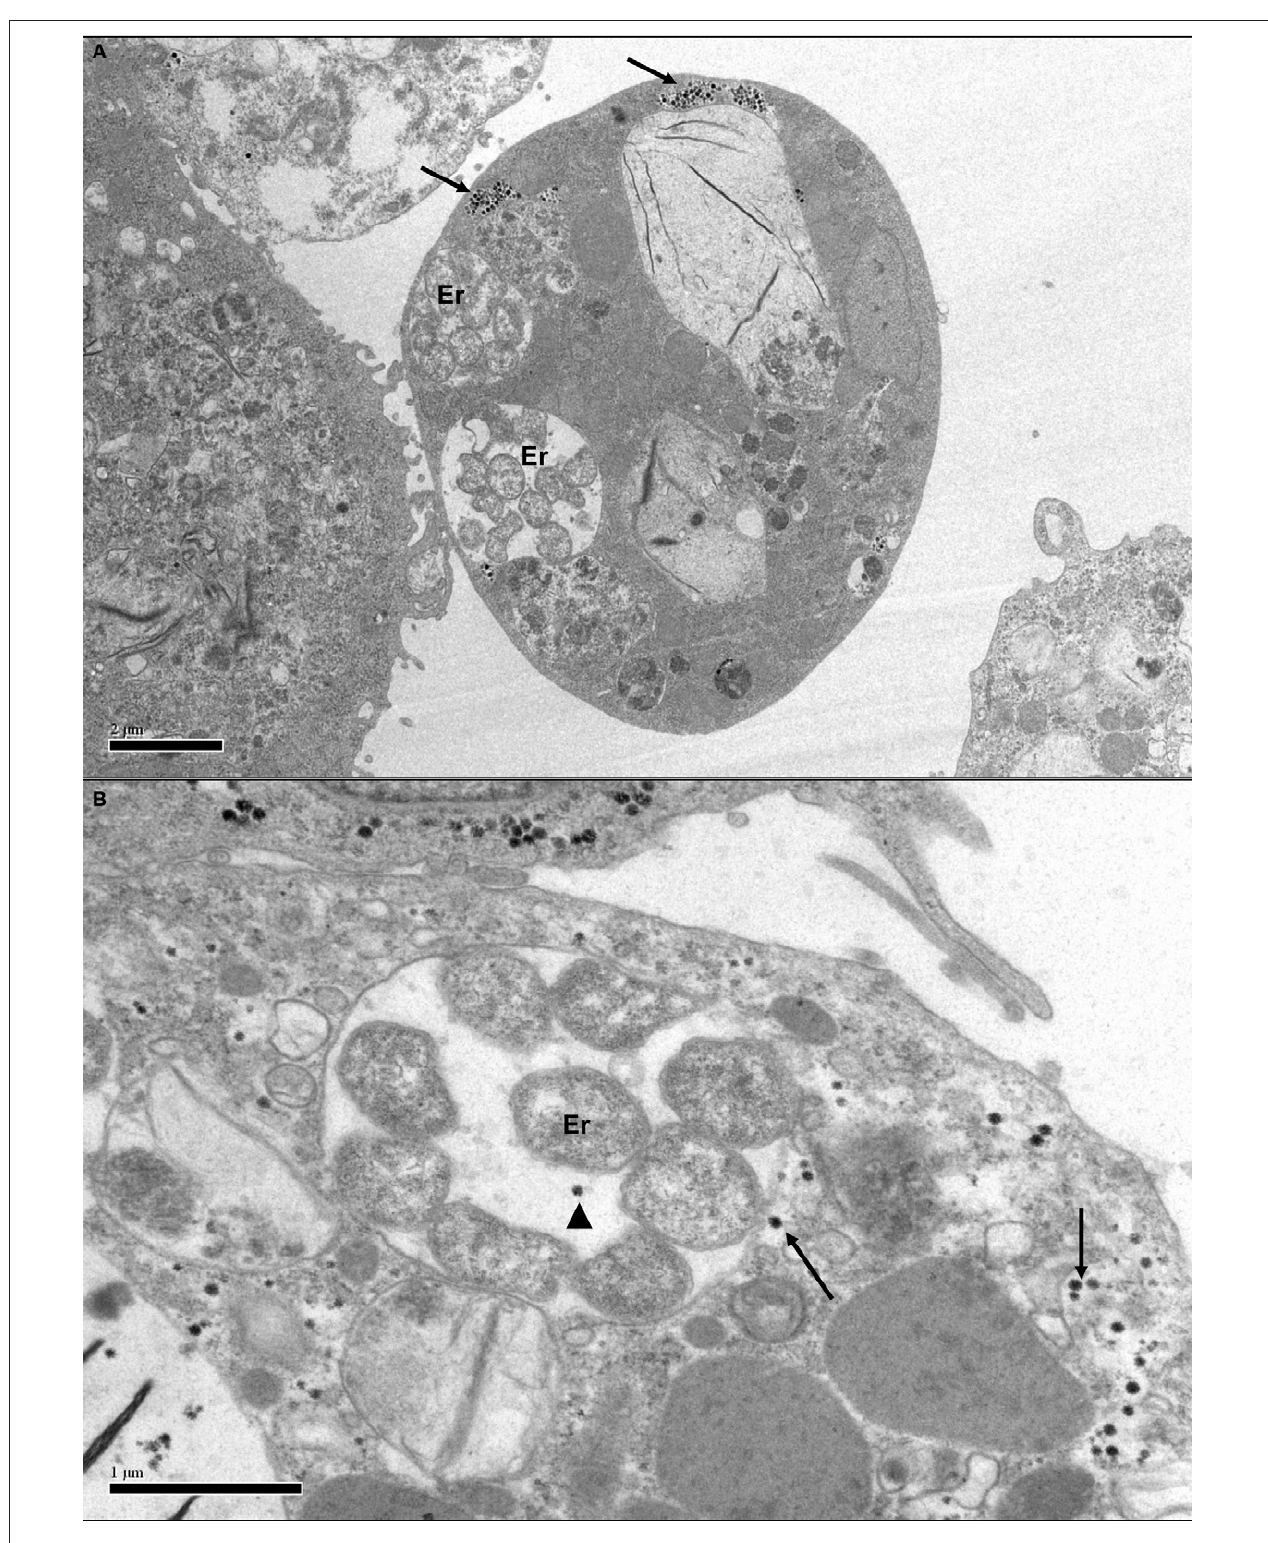
FIGURE 4 | Transmission electron micrographs of Ixodes scapularis cell line IDE8 infected with Ehrlichia ruminantium . (A) IDE8 cell showing membrane-bound intracytoplasmic morulae containing several E. ruminantium bacteria (Er) co-infecting the same cell as SCRV